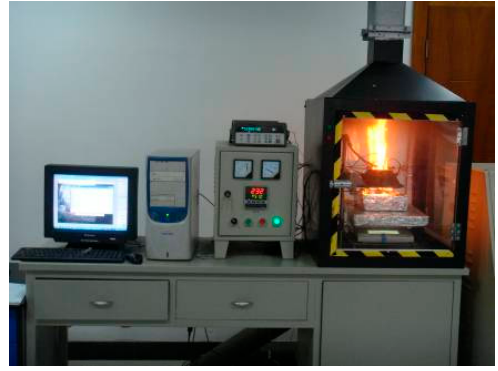
Figure 2. Experimental equipment of XPS panel exposure to heat radiation. Table 2. Radiation heat flux of each experiment.